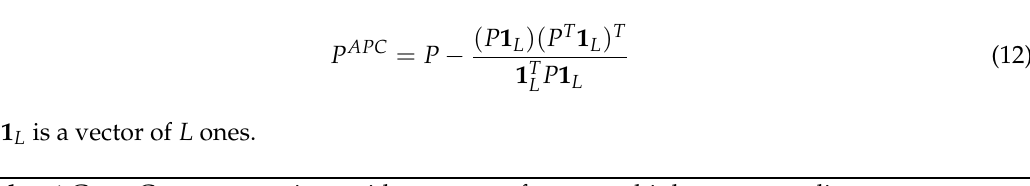
Algorithm 1 GaussCovar: extracting residue contacts from a multiple sequence